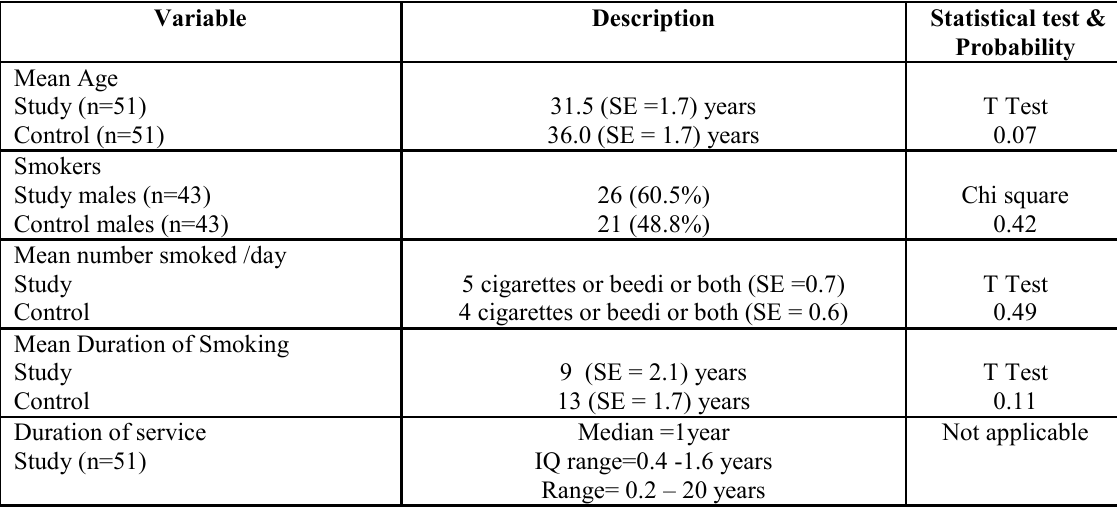
Table 1 – Description of relevant variables among granite workers and the control